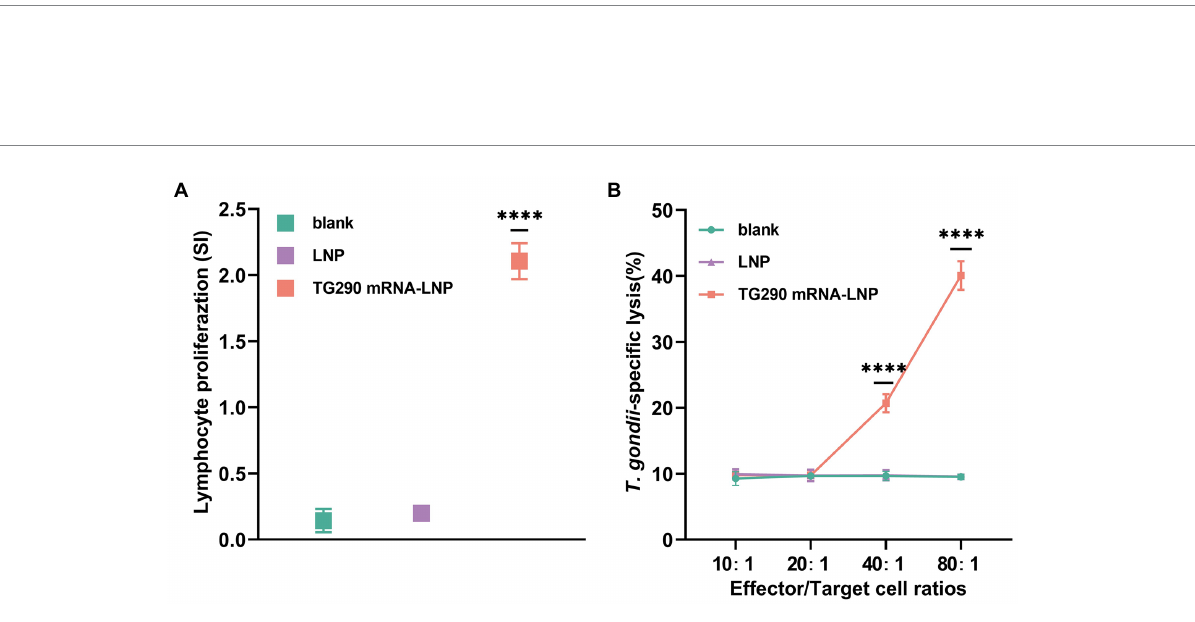
FIGURE 5 Proliferation and CTL activity of lymphocytes in immunized BALB/c mice. (A) The proliferative responses of splenocytes in immunized BALB/c mice. SI, stimulation index. (B) CTL activity of spleen lymphocytes in TG290 mRNA-LNP immunized mice. The horizontal axis indicates the effector-to-target cell ratios. The vertical axis shows the percentage of T. gondii -specific lysis. Data were obtained from triplicate independent experiments and are presented as means ± SD ( n = 5). **** p < 0.0001, analyzed by One-way ANOVA with multiple comparisons (compare the mean of each group with the mean of every other